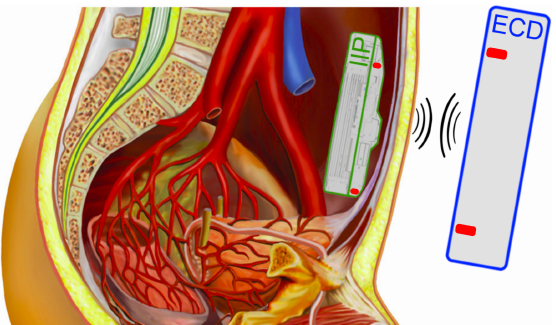
Figure 10. Schematic representation of the inductive link application, with the External Controlling Device (ECD) outside the body ( blue ), the Implantable Infusion Pump (IIP) inside the abdominal cavity ( green ) and the indicated transmission coils ( red